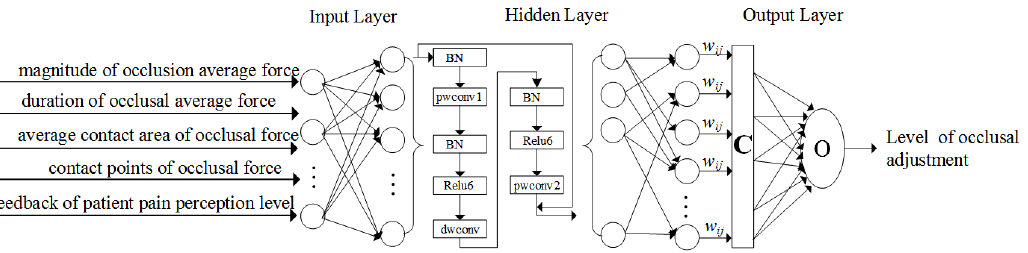
Figure 4. Neural network model designed in the present study.